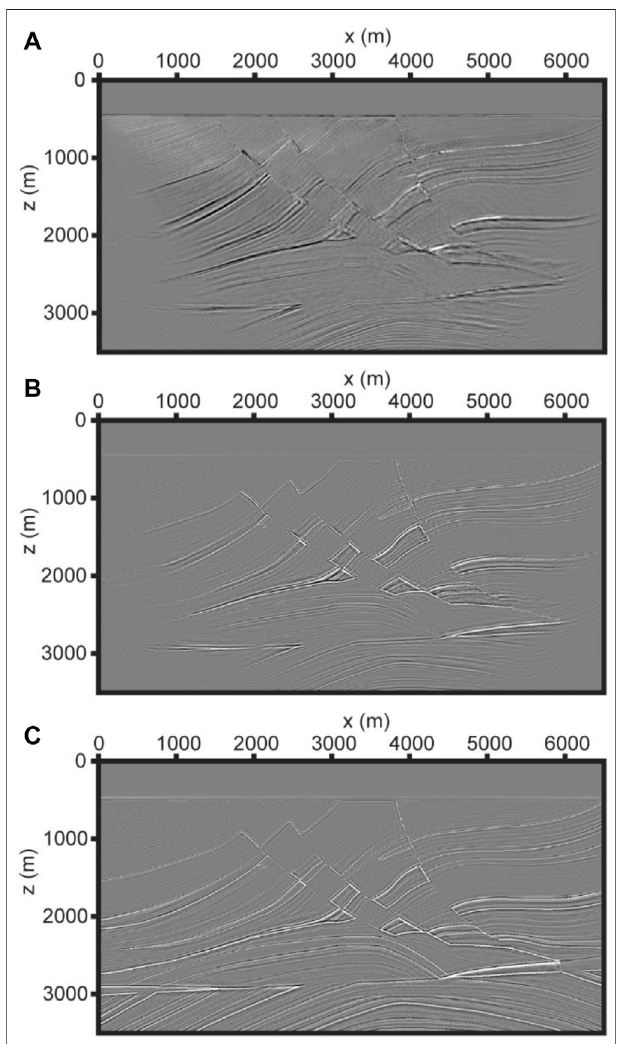
FIGURE 4 | (A) The migration image of the cross-correlation imaging conditions without wave fi eld decomposition and wave fi eld separation, using the fi rst-order velocity-stressequations. (B) The migration image of the cross- correlation imaging condition with wave fi eld separation, using the fi rst- order velocity-stress equations. (C) The migration image uses the imaging condition of Eq. 6 and the elastic wave equations of Eq. 1 .